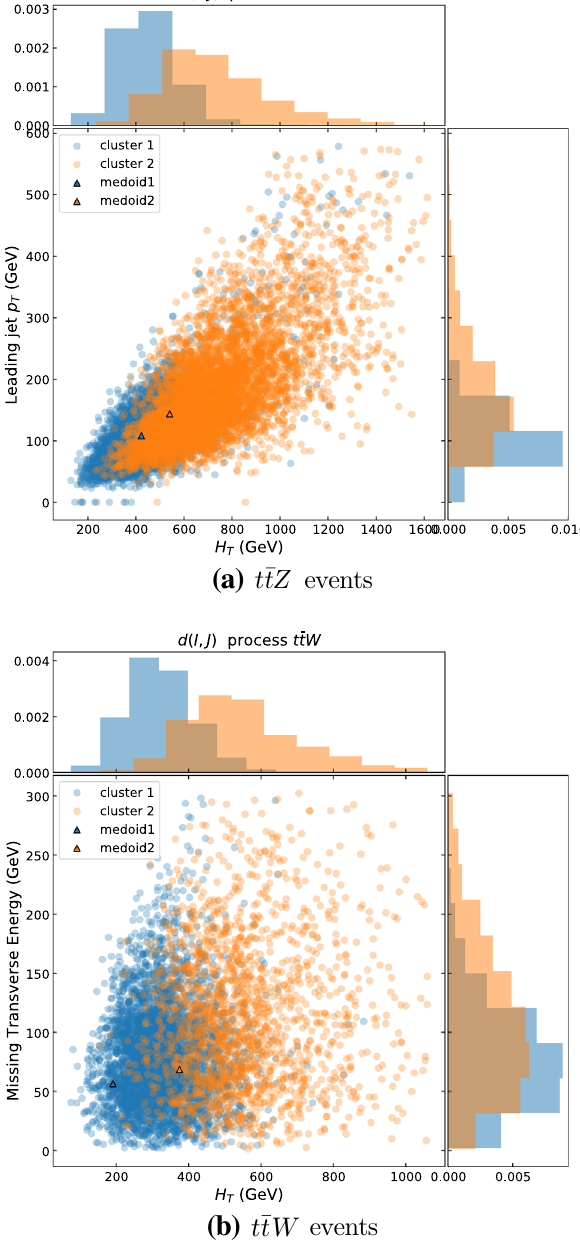
Fig. 1 Distribution of a t ¯ tZ event clusters in the (jet p T , HT ) plane and b t ¯ tW events in the ( MET , HT ) plane, and respective medoids